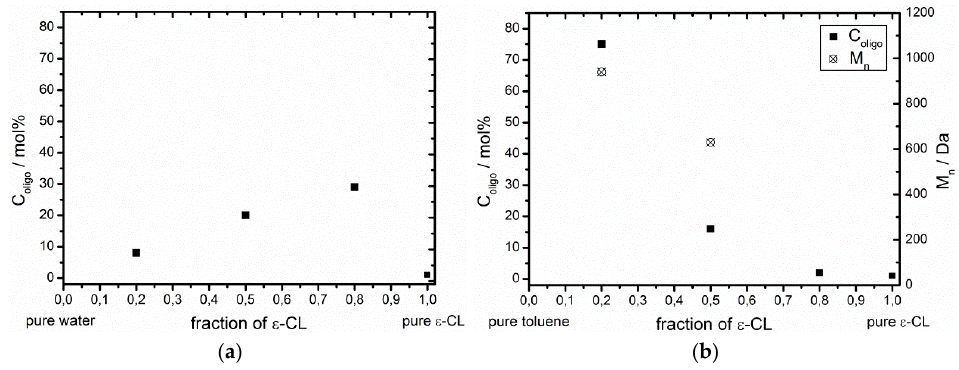
Figure 2. Conversion to oligomeric products C oligo determined by 1 H-NMR spectroscopy and M n values by SEC for the CaLB catalyzed polyesterification of ε -CL in ( a ) water and ( b ) toluene with varying ε -CL concentrations (water content ε -CL: 1530 ppm, toluene: 266 ppm).